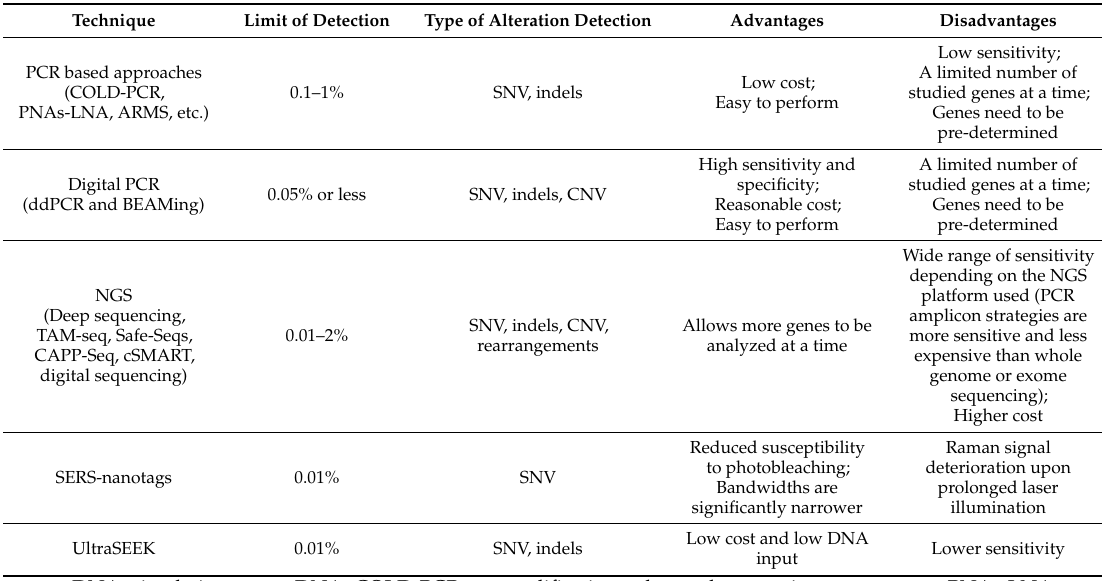
Table 2. A summary of ctDNA detection techniques (adopted from References [73,74]). Technique Limit of Detection Type of Alteration Detection Advantages